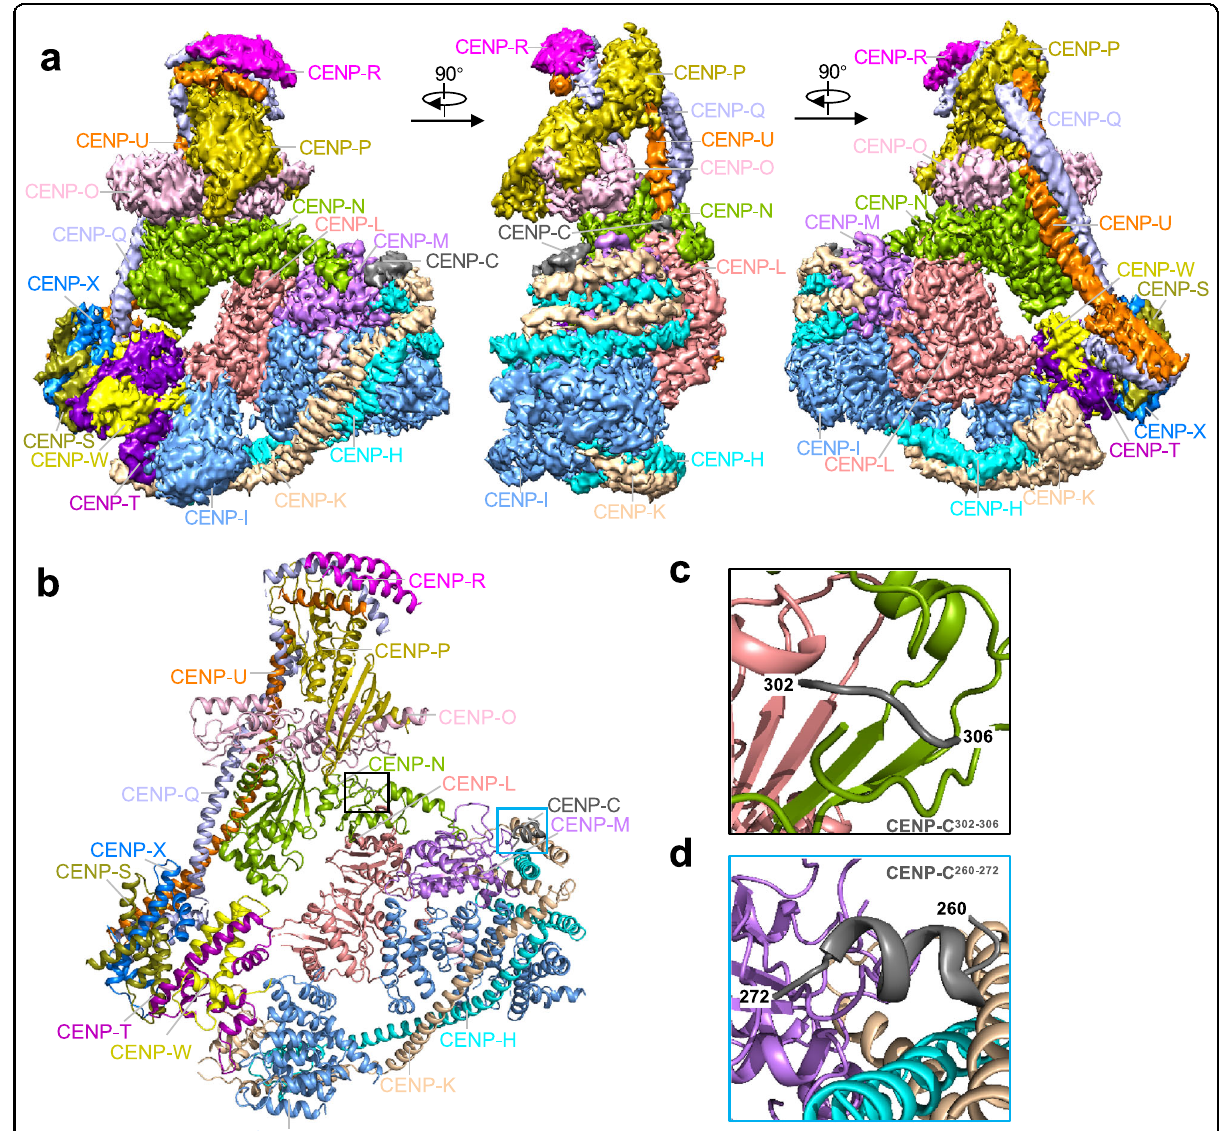
Fig. 1 Cryo-EM structure of the human CCAN complex. a The 3.3 Å-resolution cryo-EM density map of the CCAN complex at three different views. b Cartoon representation of the CCAN structure model. All subunits are assigned into fi ve sub-complexes, including CENP-C, CENP-LN, CENP-HIKM, CENP-OPQUR and CENP-TWSX. The black and blue box showed the fragment of CENP-C. c , d Enlarged view of the fragment of CENP-C show in b . Interface underlying CENP-C 302 – 306 interactions with CENP-L ( c , black frame). CENP-C 260 – 272 interacts with CENP-HKM ( d , blue frame). See also Supplementary Figs. S1 –